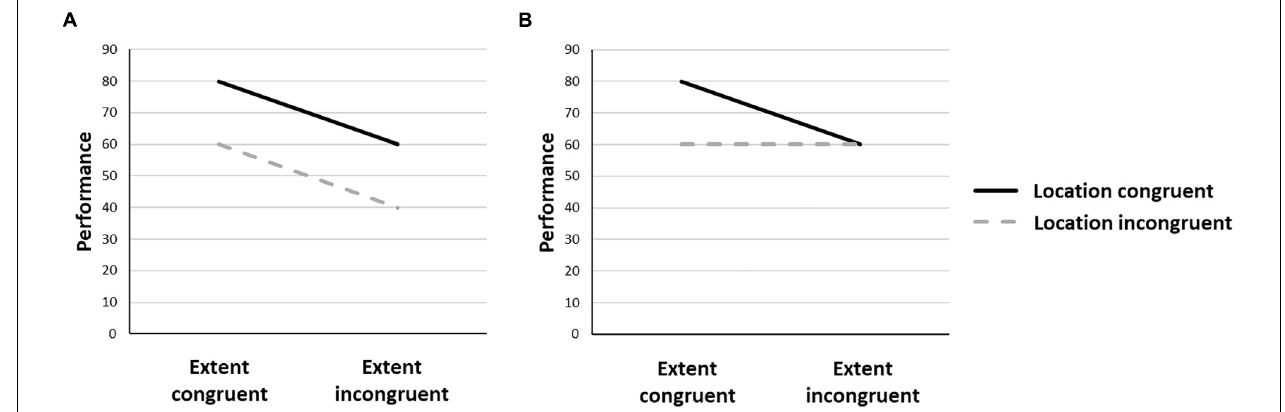
FIGURE 1 | Predicted patterns of performances in the case of distinct (A) or single (B) representational objects accounting for the number/location and number/spatial extent